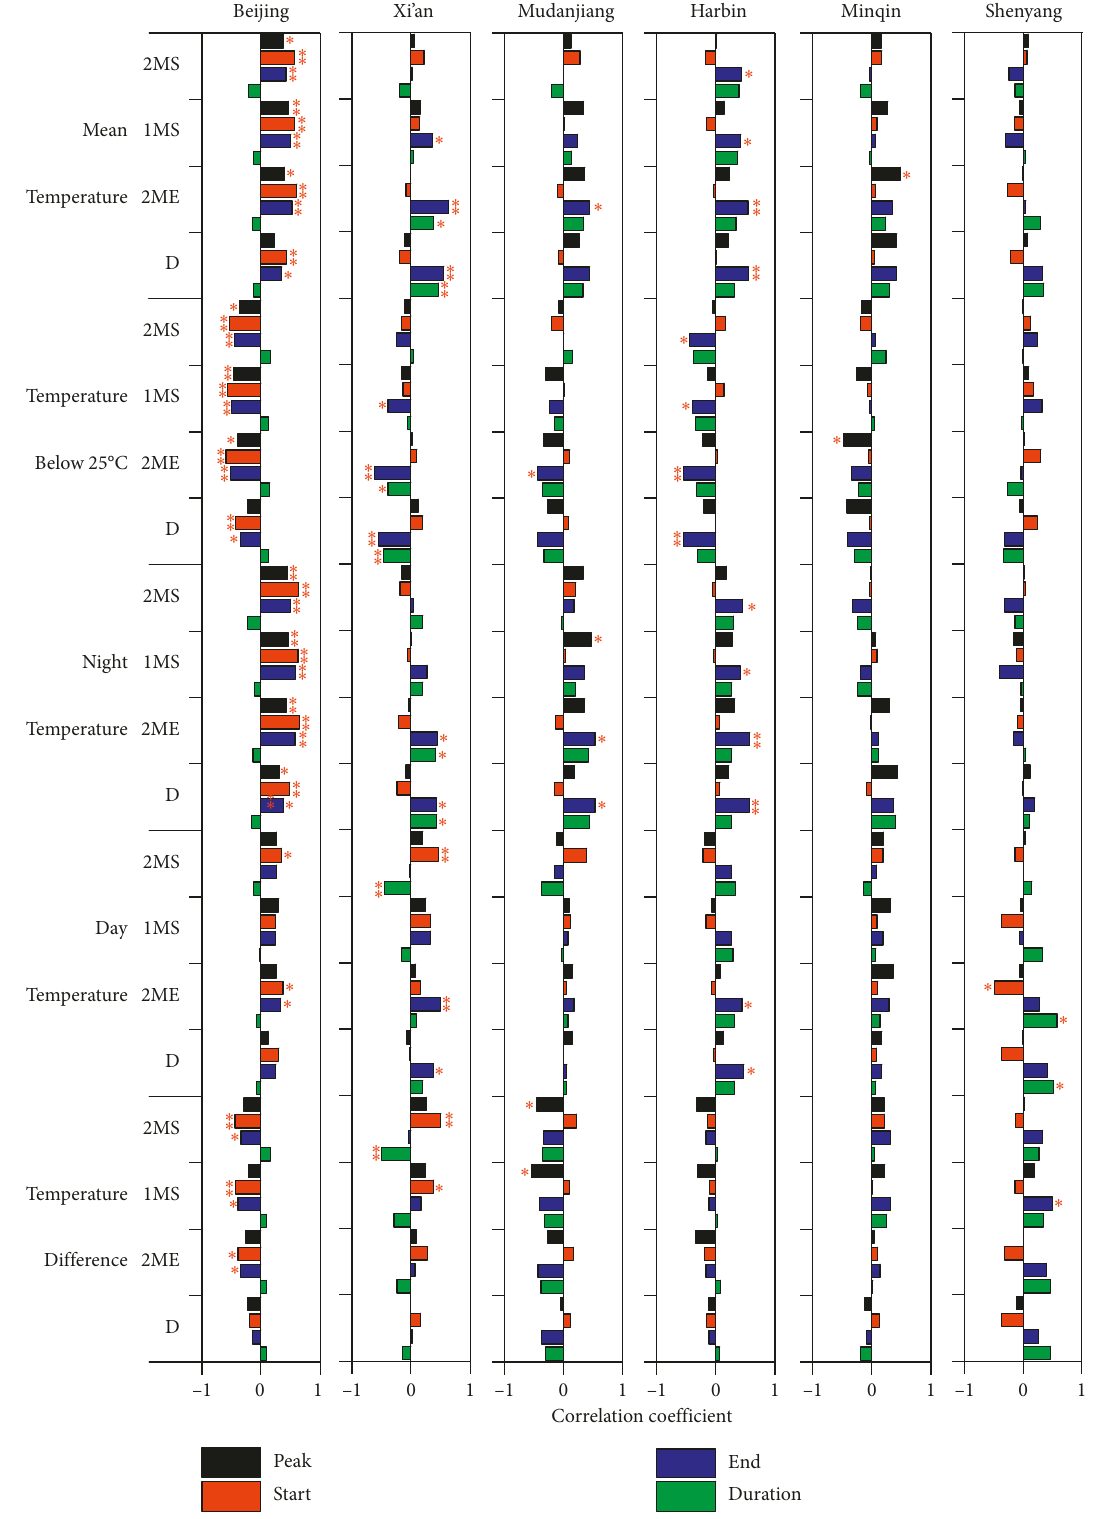
Figure 7: The correlation coefficient between the peak, start, end, and duration of the leaf coloring season and five temperature parameters in four periods at six